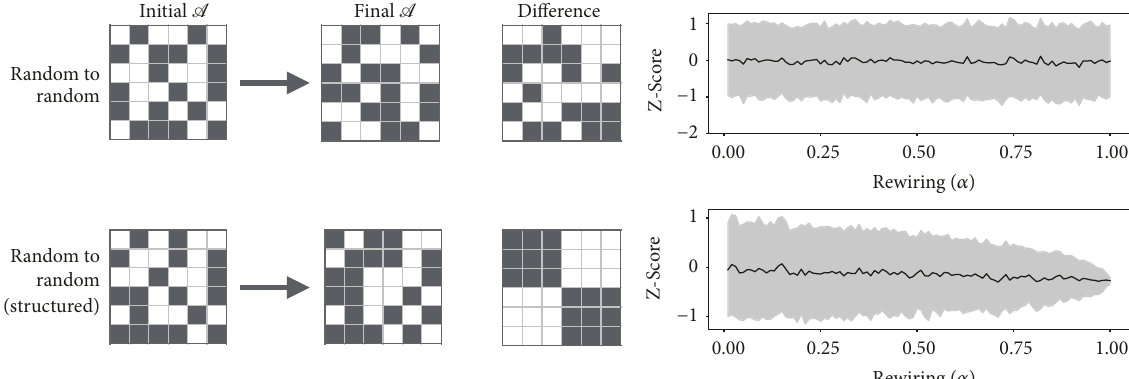
Figure 2: Evolution of the Z-Score of the von Neumann entropy, as a function of the rewiring 𝛼 , and for two synthetic networks. Panel meanings are as in Figure 1.